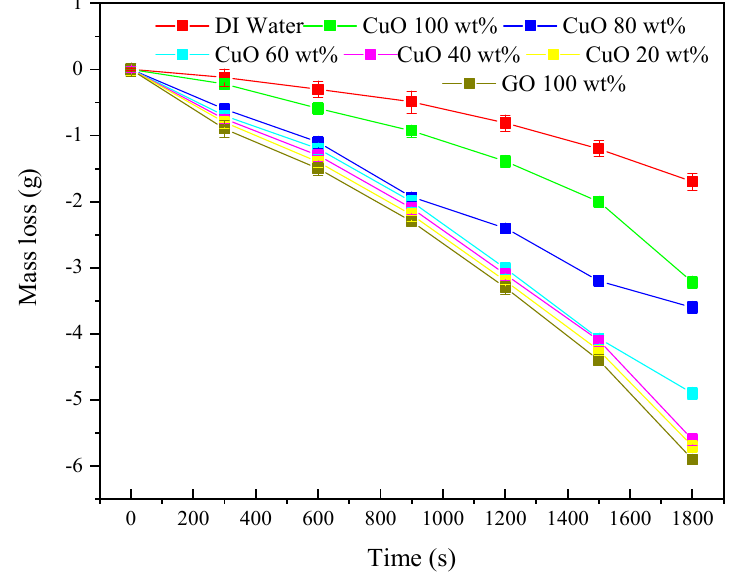
Figure 9. Mass loss for a specific time duration for binary nanofluids CuO–GO under natural sun over the period of 1800 s of DI water base nanofluids at 0.0004 wt % concentration.